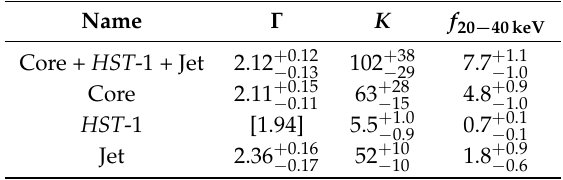
Table 1. Best-fit spectral model parameters [13]. The power-law model of the photon flux is defined as N ( E ) = KE − Γ , where E is the energy in keV, Γ is the photon index, and K is the normalization in units of 10 − 5 photonskeV − 1 cm − 2 s − 1 at 1keV. Here, the flux f = The Γ parameter of HST -1 cannot be constrained in the joint fit and is fixed to the value determined with Chandra